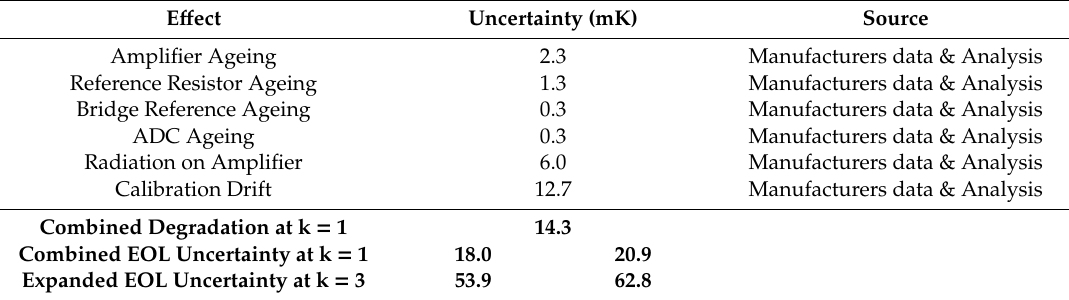
Table 4. SLSTR-A black-body temperature measurement uncertainty estimates due to degradation e ff ects over the 7.5-year mission lifetime in addition to the terms identified Table 3. The combined End of Life (EOL) uncertainty estimate includes the BOL estimates and the predicted degradation e ff